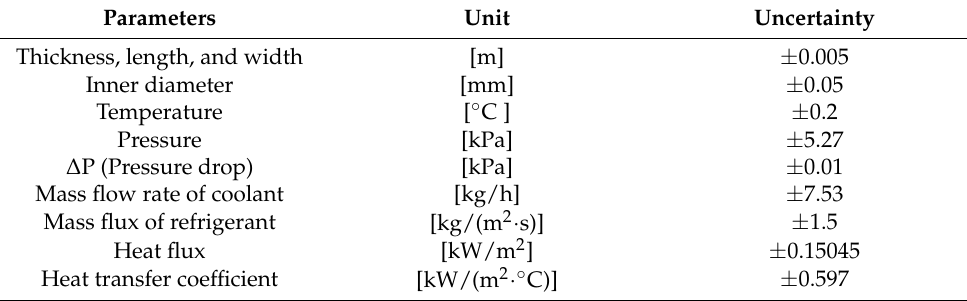
Table 3. Parameters and estimated